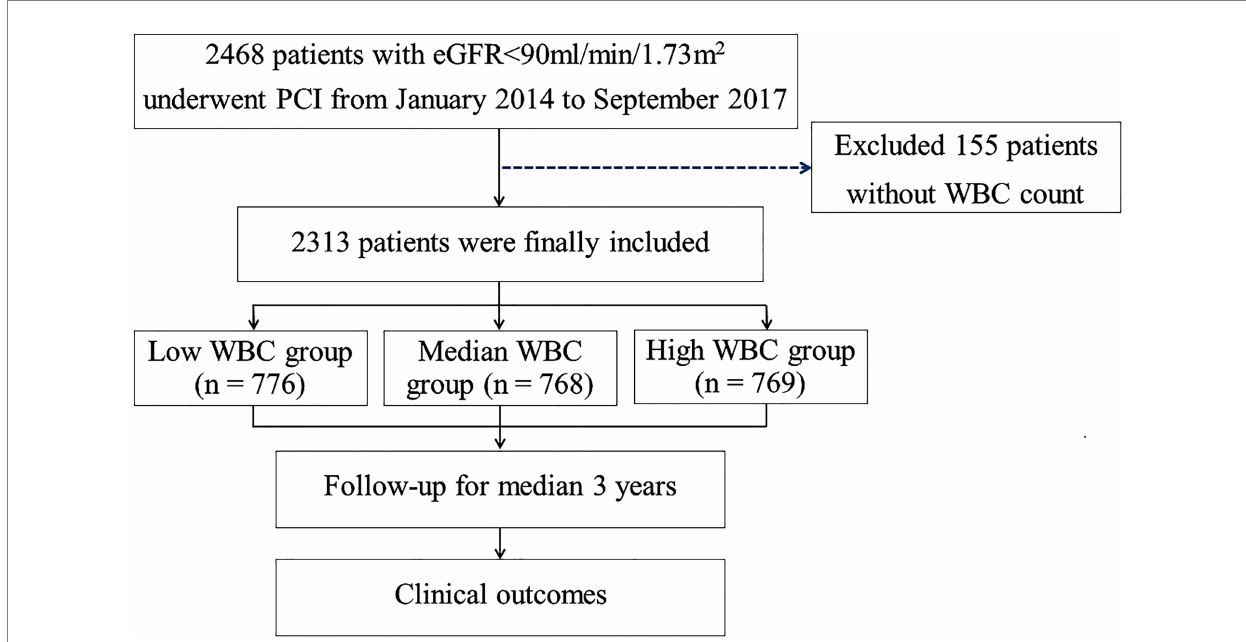
FIGURE 1 Study flow chart. PCI, percutaneous coronary intervention; eGFR, estimated glomerular filtration rate; CABG, coronary artery bypass graft; WBC, white blood